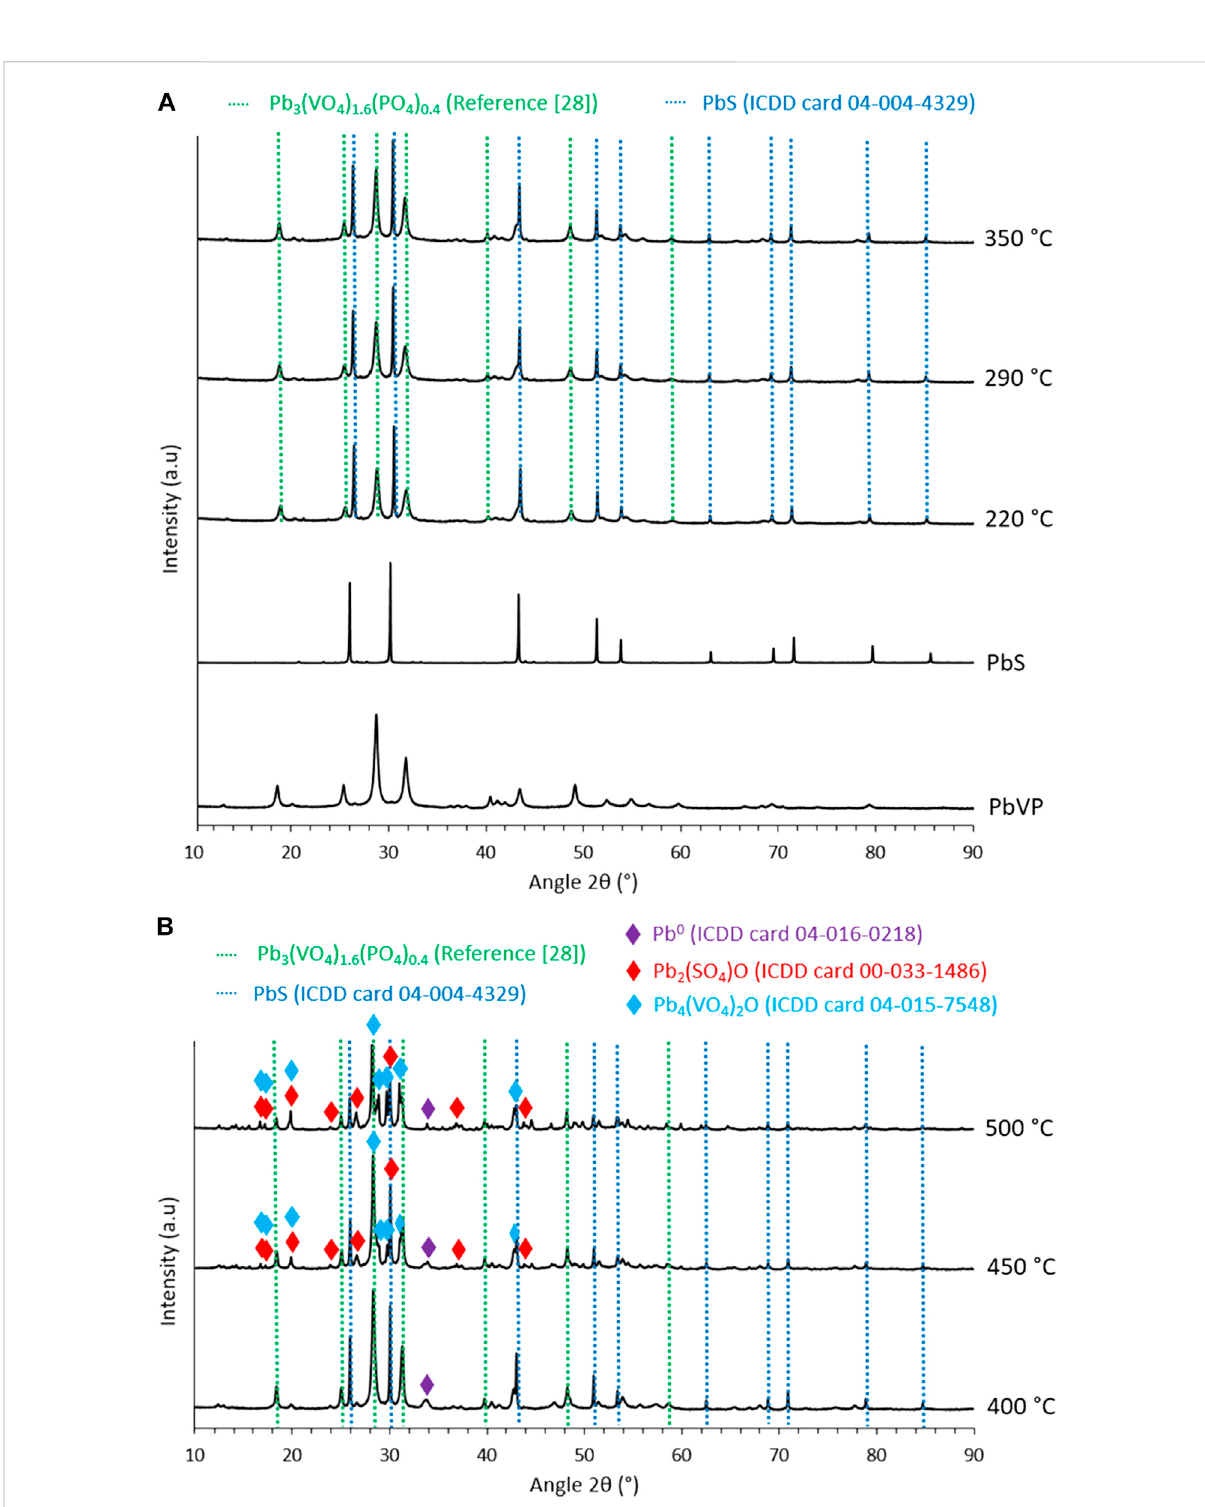
FIGURE 2 X-Ray diffractograms of (A) PbVP, PbS, lead-vanadate sorbents calcined at 220, 290, 350 ° C and (B) calcined at 400, 450 and 500 °